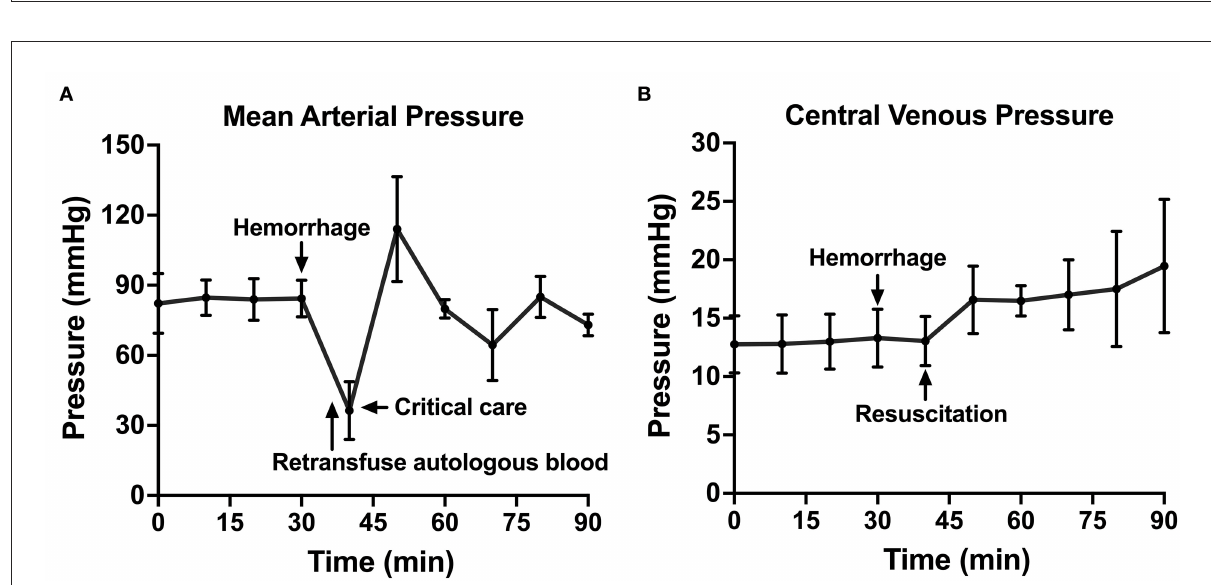
FIGURE4 The hemodynamic variables across time: (A) Mean arterial pressure shown throughout baseline, hemorrhage, retransfusion of autologous blood, and a critical care period with intravenous fluid, if needed, and (B) central venous pressure shown throughout baseline, hemorrhage, and a similar resuscitation